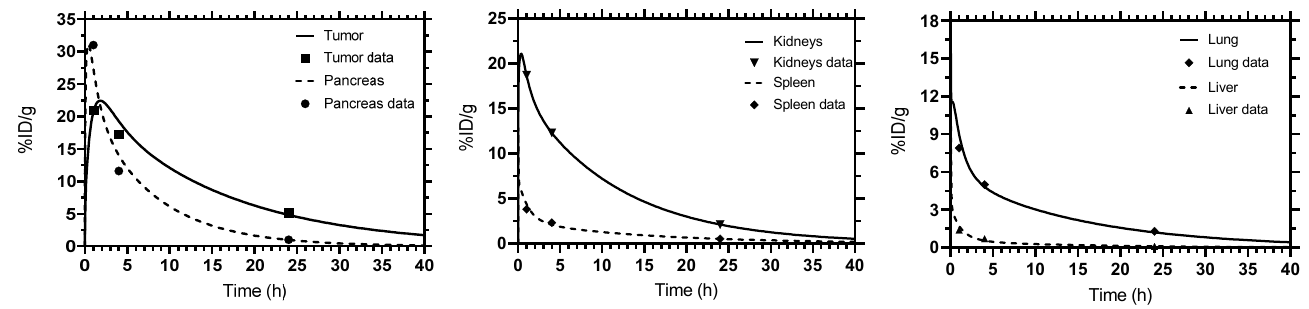
Figure 4. Fitted time–activity curves. Simbiology and SAAM II gave identical results. Table 1. Pharmacokinetic parameter values obtained from the 212 Pb-SSTA-PBPK model fit to experimental data [4]. Parameter